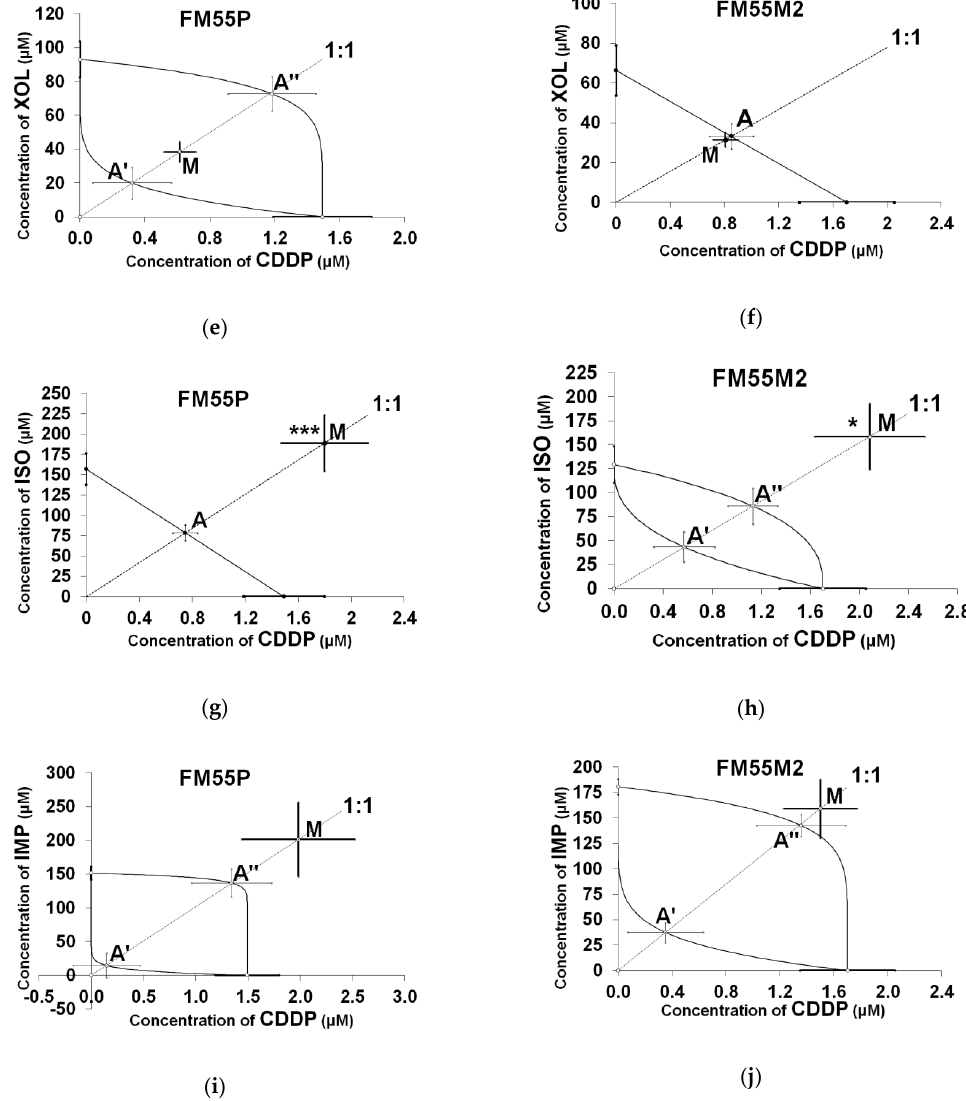
Figure 2. Isobolograms showing additive and synergistic interactions between cisplatin (CDDP) and osthole (OST) for the human melanoma cell line FM55P ( a ) and for cell line FM55M2 ( b ), respectively. Isobolograms showing antagonistic and additive interactions between cisplatin (CDDP) and xanthotoxin (XIN) for the FM55P cell line ( c ) and the FM55M2 cell line ( d ), respectively. Isobolograms illustrating additive interaction between cisplatin (CDDP) and xanthotoxol (XOL) for both FM55P and FM55M2 cell lines ( e , f ). Isobolograms showing antagonistic interaction between cisplatin (CDDP) and isopimpinellin (ISO) for both FM55P and FM55M2 cell lines ( g , h ). Isobolograms illustrating additive interaction with a tendency toward antagonism between cisplatin (CDDP) and imperatorin (IMP) for both FM55P and FM55M2 cell lines ( i , j ). The median inhibitory concentrations (IC 50 ) for CDDP and the tested coumarins (OST, XIN, XOL, ISO, and IMP) are plotted on the x - and y -axes, respectively. The solid lines on the x- and y -axes represent the S.E. for the IC 50 values for the studied drugs, when administered alone. The lower and upper isoboles of additivity represent the curves connecting the IC 50 values of CDDP and the tested coumarins administered alone, if their concentration-response relationships were nonparallel. For collateral concentration-response relationships between CDDP and the studied coumarins, the isobole represents the straight diagonal line connecting the IC 50 values. The dotted line starting from the point (0,0) corresponds to the fixed ratio of 1:1 for the combination of CDDP with each of the tested coumarins. The points A’ and A” depict the theoretically calculated IC 50 add values for both lower and upper isoboles of additivity. The point M represents the experimentally derived IC 50 exp value for a total dose of the mixture expressed as proportions of CDDP and each of the tested coumarins that produced a 50% antiproliferative effect in the FM55P and FM55M2 cell lines, as measured in vitro by the MTT assay. * p < 0.05 and *** p < 0.001 vs. the respective IC 50 add